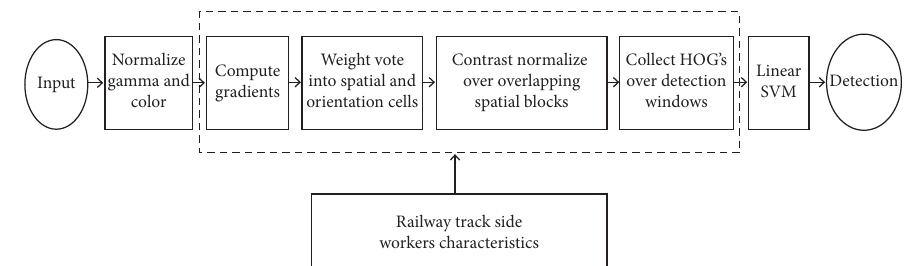
Figure 4: HOG descriptor and SVM